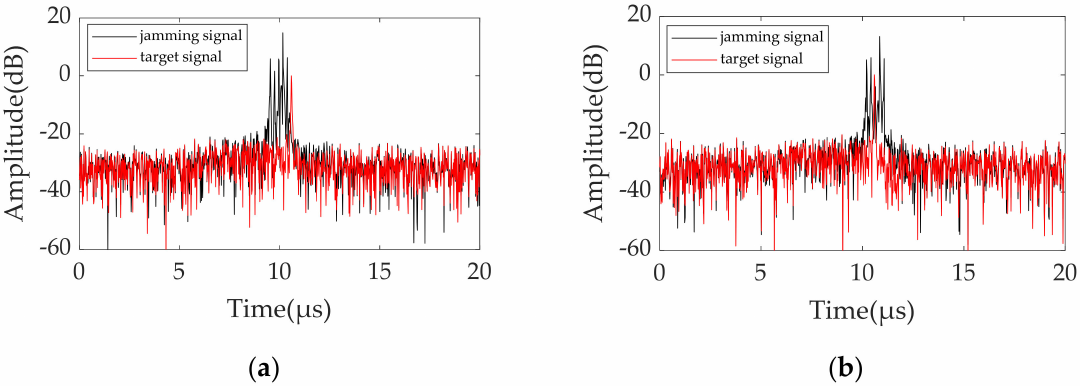
Figure 5. Pulse compression imaging results of the LFM signal and jamming signal. ( a ) Jamming results with only time delay sequence; ( b ) jamming results with frequency delay sequence.